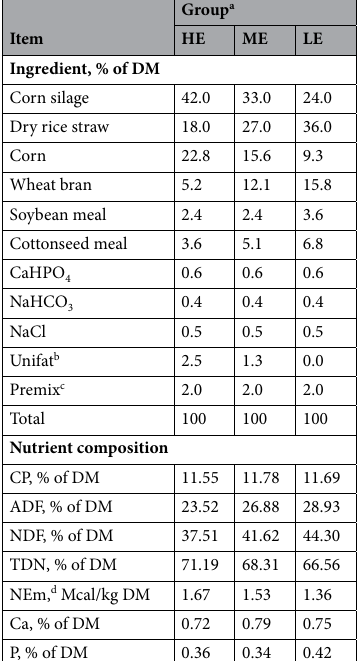
Table 1. Average weekly chemical composition of total mixed diets (HE, ME and LE) offered to mature cows during the last 45 d of gestation (d 0 to calving). a HE = high energy (NEm = 1.67 Mcal/kg of DM); ME = medium energy; (NEm = 1.53 Mcal/kg of DM); LE = low energy (NEm = 1.39 Mcal/kg of DM). b Fractionated palm fatty acids (China Benefit Agriculture, Beijing, China). c Premix contained (per kg of premix): 480,000 IU of vitamin A, 90,000 IU of vitamin D 3 , 3,500 IU of vitamin E, 2400 mg of Fe, 168 g of Ca, 38 g of P, 950 mg of Cu, 1,500 mg of Mn, 3,150 mg of Zn, 28 mg of I, 33 mg of Se, and 26 mg of Co. d NEm was calculated based on NRC